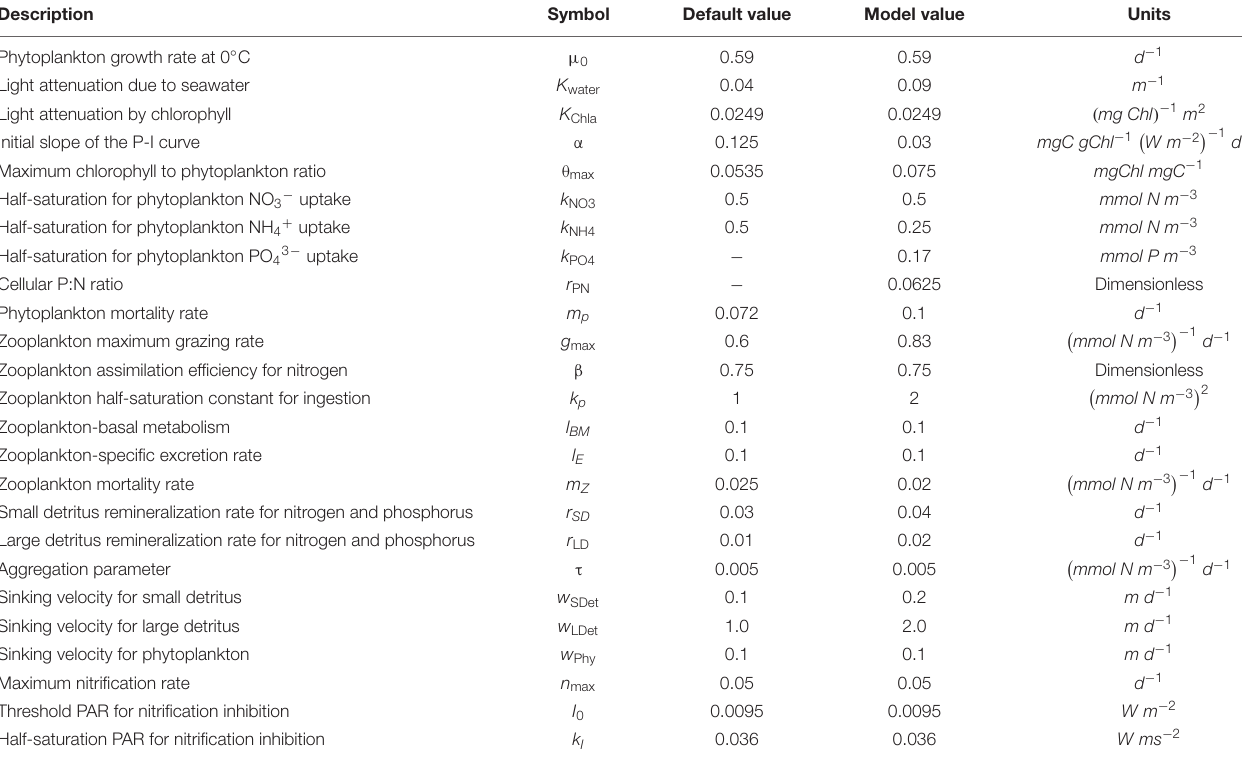
TABLE 1 | Biogeochemical model parameters used in this study and default values from Fennel et al. (2006).